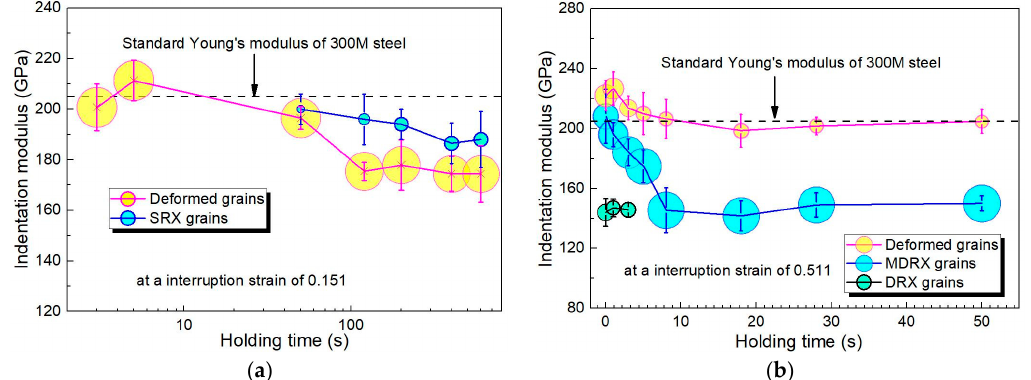
Figure 9. Variation of Young’s modulus of different types of grains with the holding time corresponding to: ( a ) sample A; ( b ) sample B. Data points correspond to average values from 160 measurements for recrystallized grains and 48 measurements for deformed grains; error bars correspond to one standard deviation about the mean values.